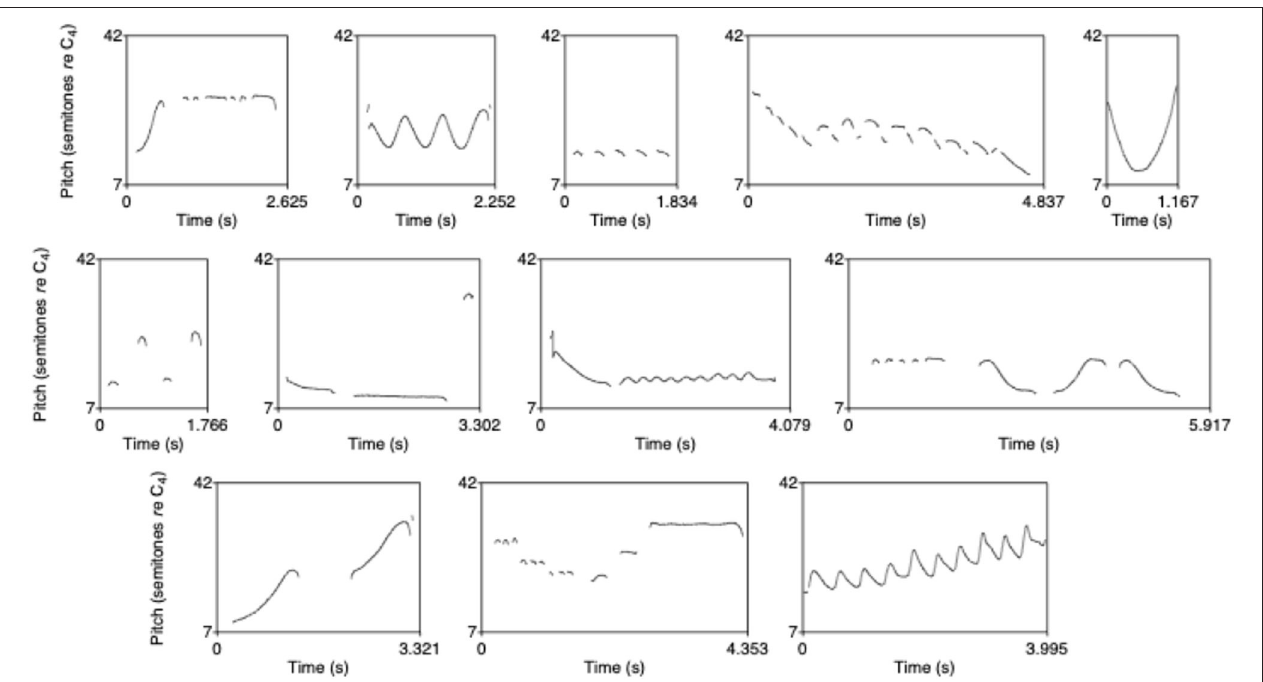
FIGURE 2 | Whistles from the initial whistle set, plotted as pitch tracks on a semitone scale (From Verhoef, 2013).